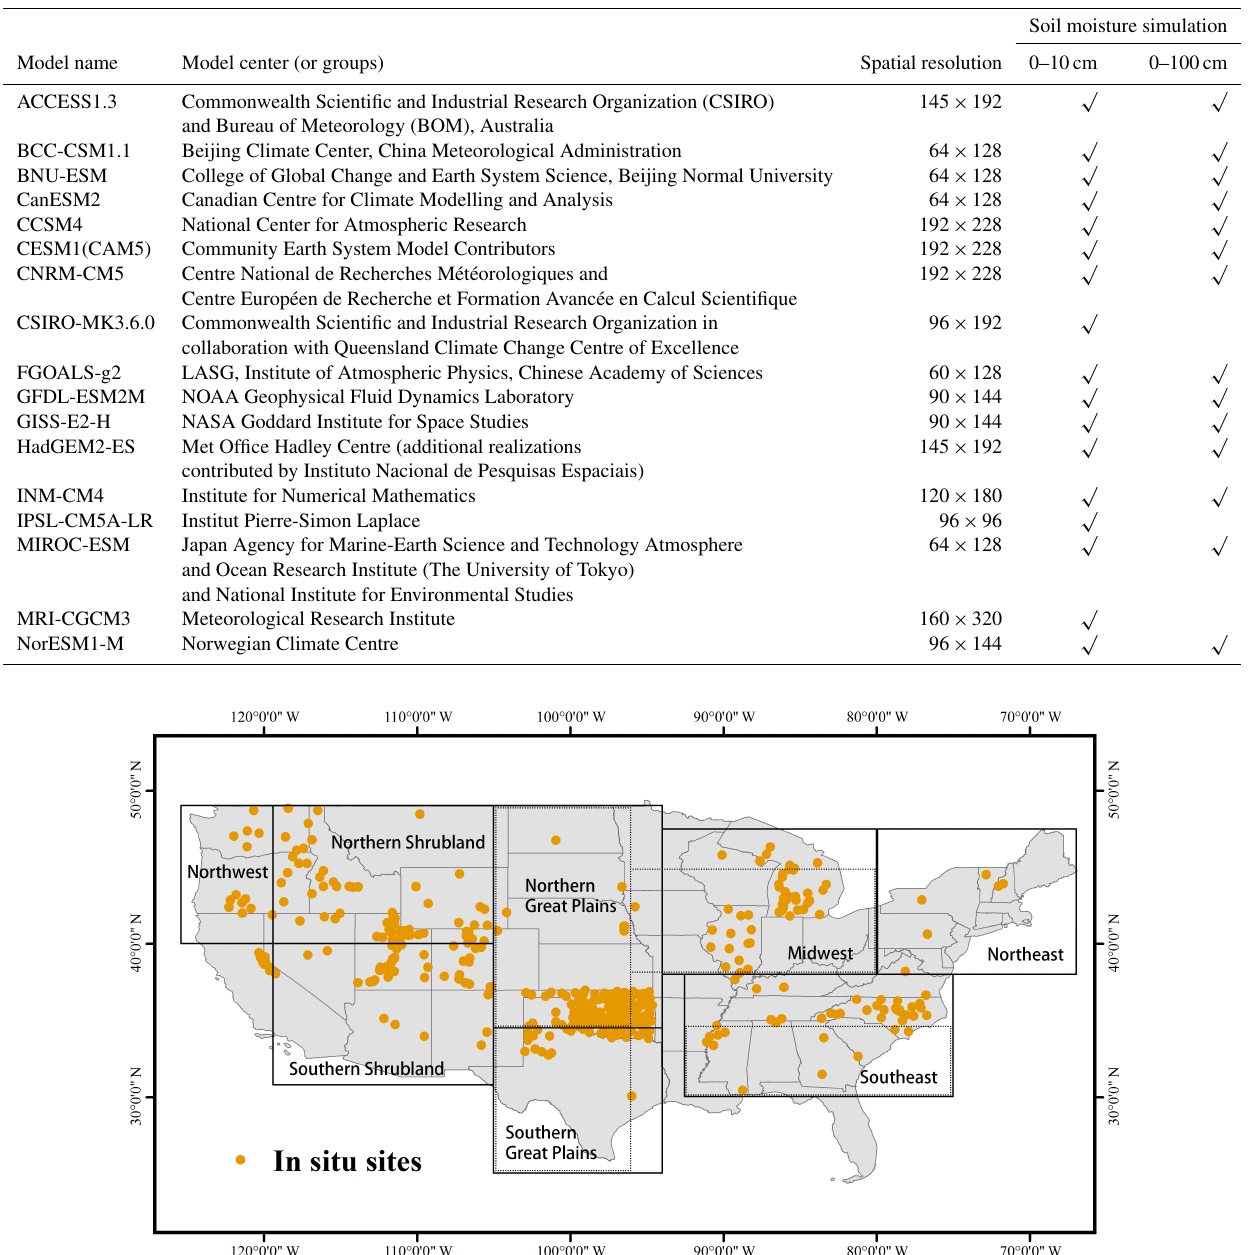
Table 1. List of 17 CMIP5 models in this study.